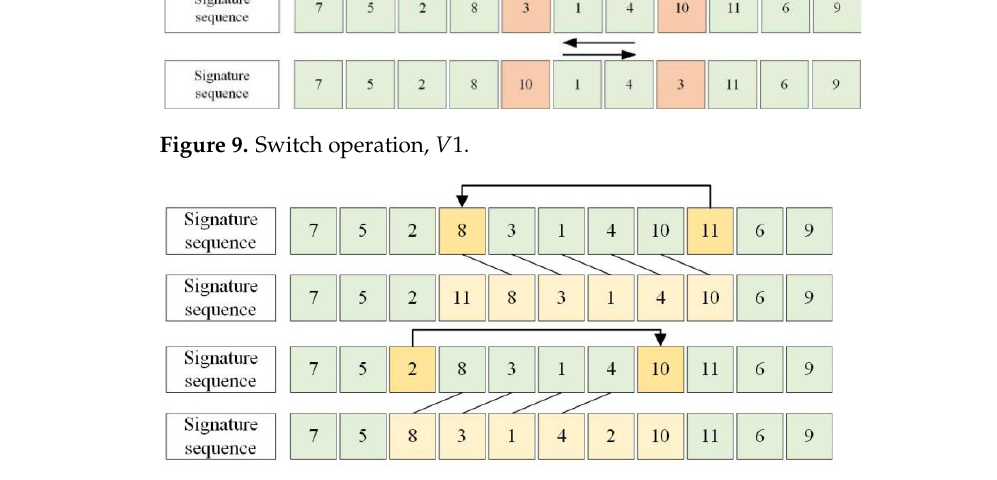
Figure 10. Insert Operation, V 2.